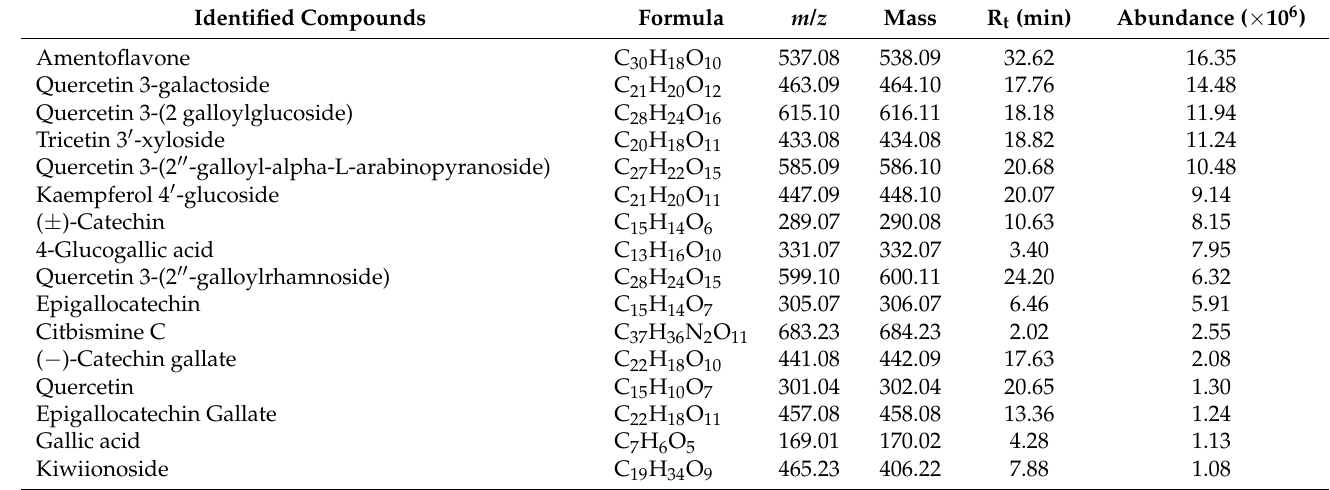
Table 5. Phenolic compounds in CLE extracted under optimized conditions were analyzed by LC/DAD/MSD in negative mode.